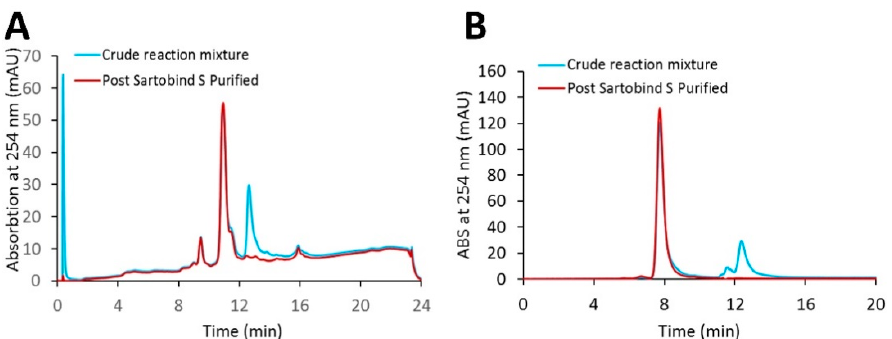
Figure 4. HPLC analytical characterization of the cys-mAb-PBD crude reaction mixture and the Sartobind ® S membrane purified conjugate. ( A ) HIC analysis. ( B ) SEC analysis. The blue line indicates the crude reaction mixture; the red line indicates the purified conjugate.